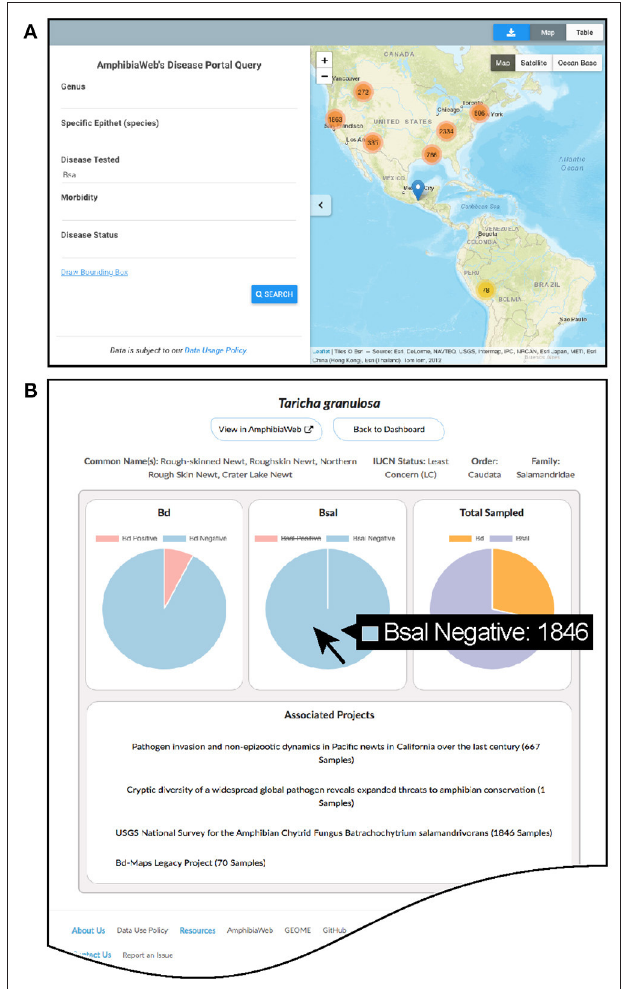
FIGURE 2 | Examples of the Amphibian Disease portal’s user-friendly pages. (A) Basic query and interactive mapping interface showing zoom-dependent clustering of data points with counts. (B) Dynamic graphing page for species showing proportion and counts of Batrachochytrium dendrobatidis ( Bd ) and B. salamandrivorans ( Bsal ) data with relevant links to projects (example species Taricha granulosa ). Hovering over pie chart will display the specific counts of samples. All graphs in the Data Dashboard section of the website are enabled by the Amphibian Disease web